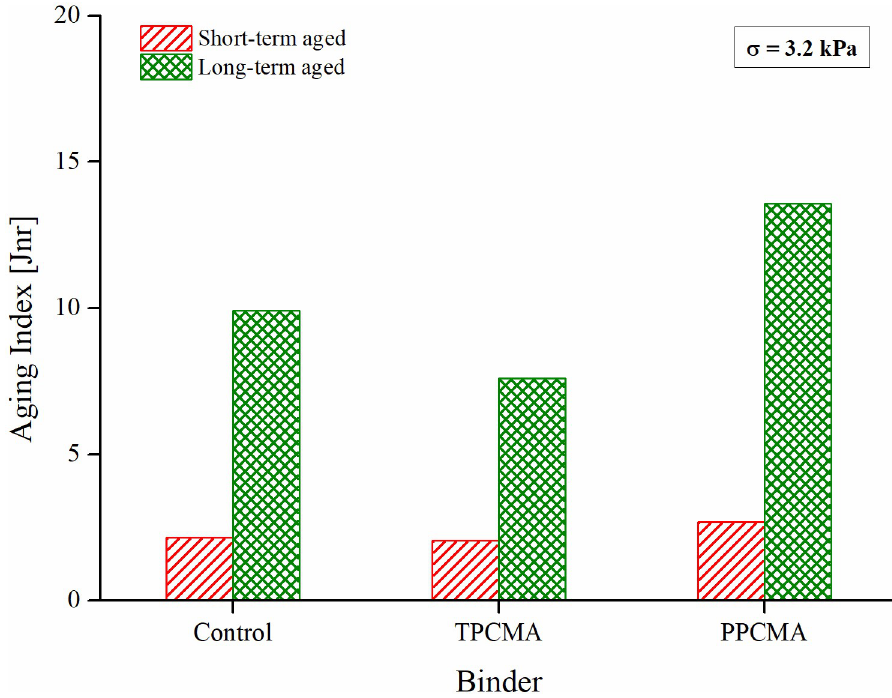
Fig 10. Aging index based on MSCR J